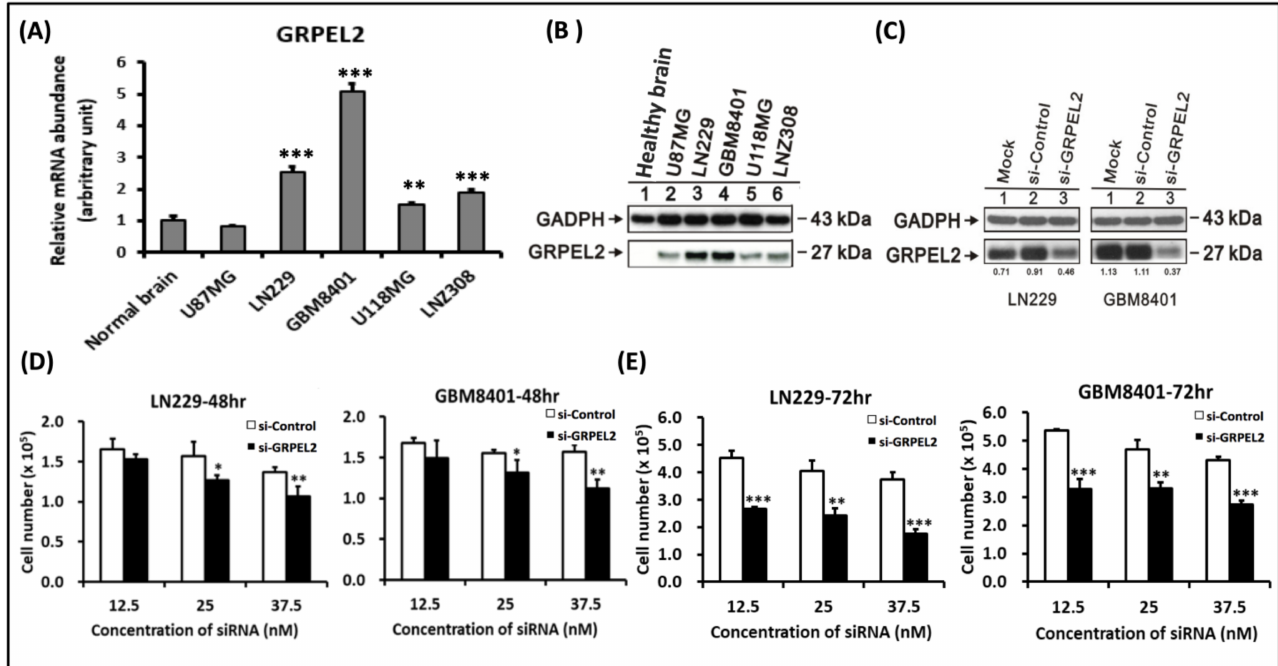
Figure 4. GRPEL2 expression was enhanced in glioma cell lines and GRPEL2 suppression inhibited cell survival. ( A ) Quan- titative RT-PCR analysis of GRPEL2 mRNA abundance in healthy brain tissue and the U87MG, the LN229, the GBM8401, the U118MG, and the LNZ308 glioma cells. ** p < 0.01, *** p < 0.001. ( B ) Western blotting analysis of GRPEL2 expression in healthy brain tissue and U87MG, LN229, GBM8401, U118MG, and LNZ308 glioma cells. ( C ) A representative Western blot validated the effect of GRPEL2 knockdown in LN229 and GBM8401 glioma cells. ( D , E ) Quantitative validation of siGRPEL2 to inhibit the cellular numbers ( × 10 5 ) of LN229 and GBM8401 glioma cells at the concentration of 12.5 nM, 25 nM, and 37.5 nM siGRPEL2 in contrast to siControl treatment for 48 and 72 h. * p < 0.05, ** p < 0.01; *** p <